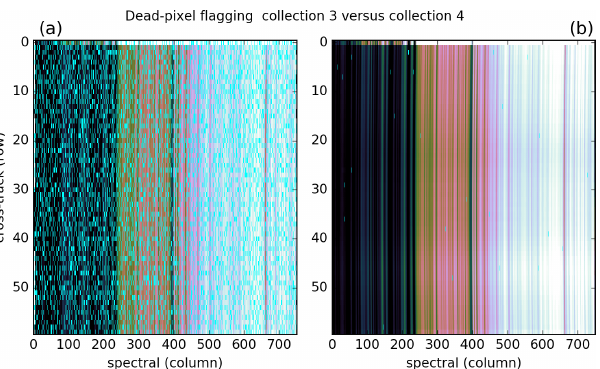
Figure 21. The VIS irradiance spectrum for all detector rows, shown as an image for orbit 89169 for collection 3 (a) and col- lection 4 (b) . The cyan dots in the left panel are fill values in the L1b data, caused by the too aggressive dead-pixel